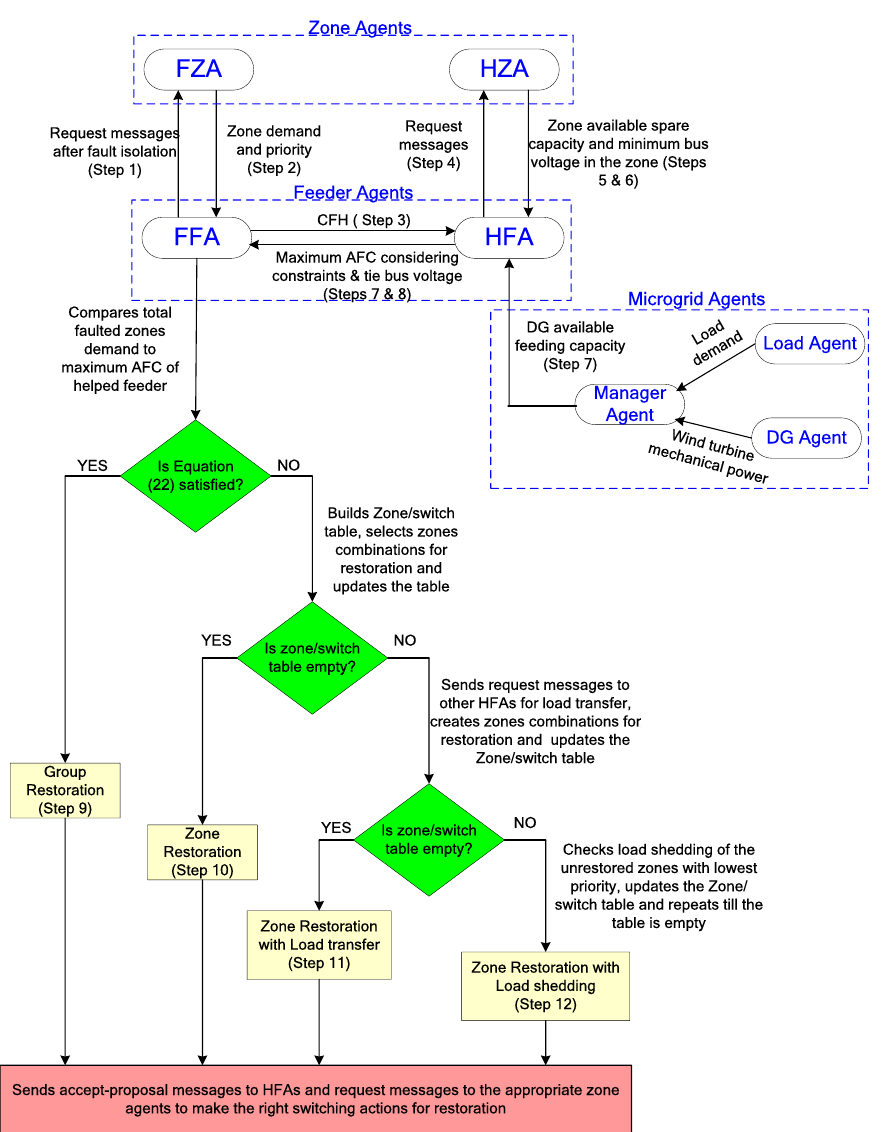
Figure 3. Illustrative diagram for the steps and agents’ roles of the proposed rest oration